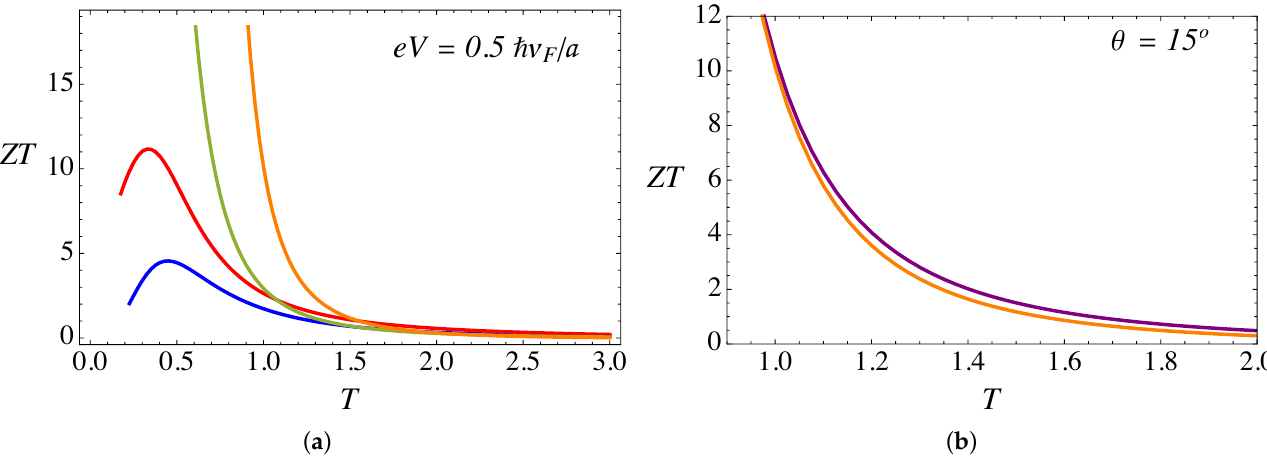
Figure 12. (Color online) ( a ) The figure of merit ZT (dimensionless) as a function of temperature (in units of ¯ h v F / k B a ), calculated for fixed B 0 a 2 = 25 ˜ φ 0 , a bias eV = 0.5 ¯ hv F / a , and α = 3 π /4. The blue line corresponds to θ = 0 ◦ , red is for θ = 5 ◦ , green is for θ = 10 ◦ , and the orange line corresponds to θ = 15 ◦ . ( b ) Comparison of the figure of merit ZT for θ = 15 ◦ : the purple line is for α = 0 whereas the orange line is for α = 3 π /4.